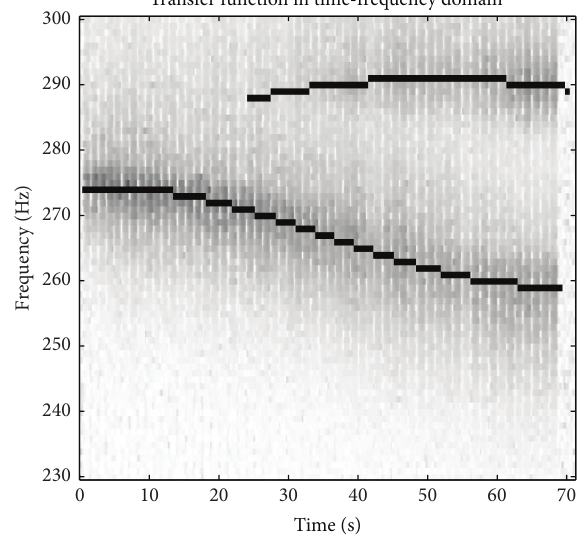
Figure 13: Experimental results obtained for the repeated impact excitation in combined time-frequency